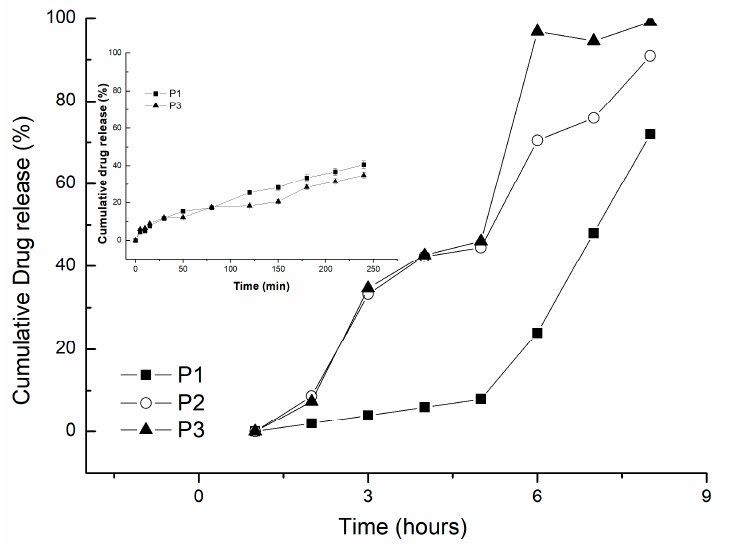
Figure 9. Drug release profiles for CS-g-PNIPAAm/PVA 80/20 +PGT (P1), CS-g-PNIPAAm/PVA 95/5 +PGT (P2), and CS-g-PNIPAAm/ PVA 75/25 +PGT (P3) hydrogels.